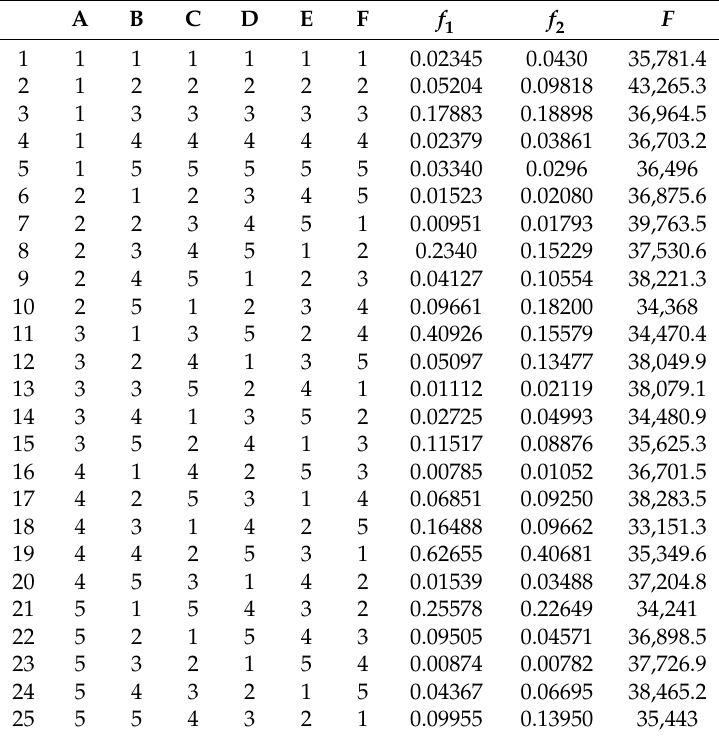
Table 3. The results of orthogonal design.